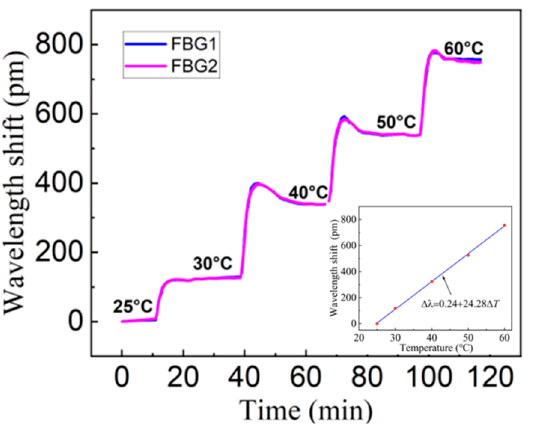
Figure 8. Wavelength shift versus time curves in the temperature compensation.